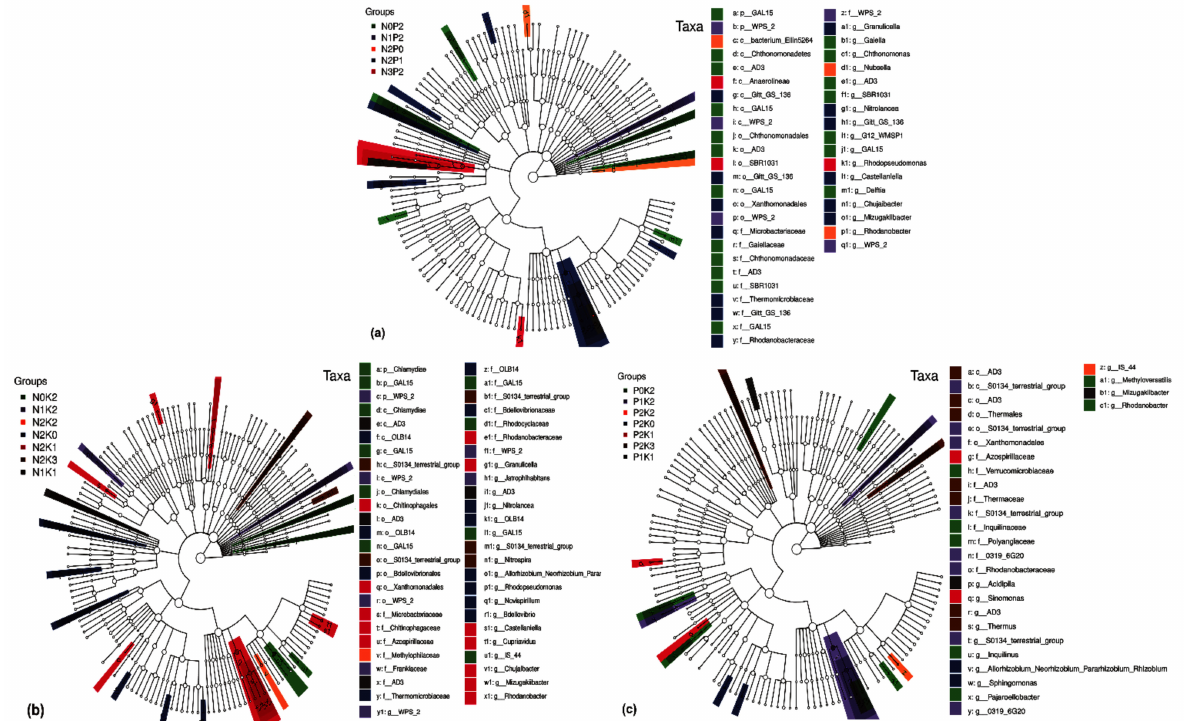
Figure 4. Analysis of soil bacterial differences of Phoebe bournei seedlings under two-factor NPK fertilization treatments. ( a ) NP fertilizer application rate changes; ( b ) NK fertilizer application rate changes; ( c ) PK fertilizer application rate